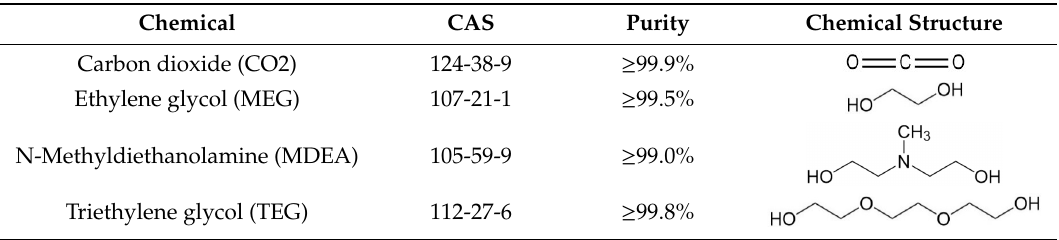
Table 1. Full names, chemical abstracts service (CAS) numbers, purity, and structures of the chemicals. Chemical